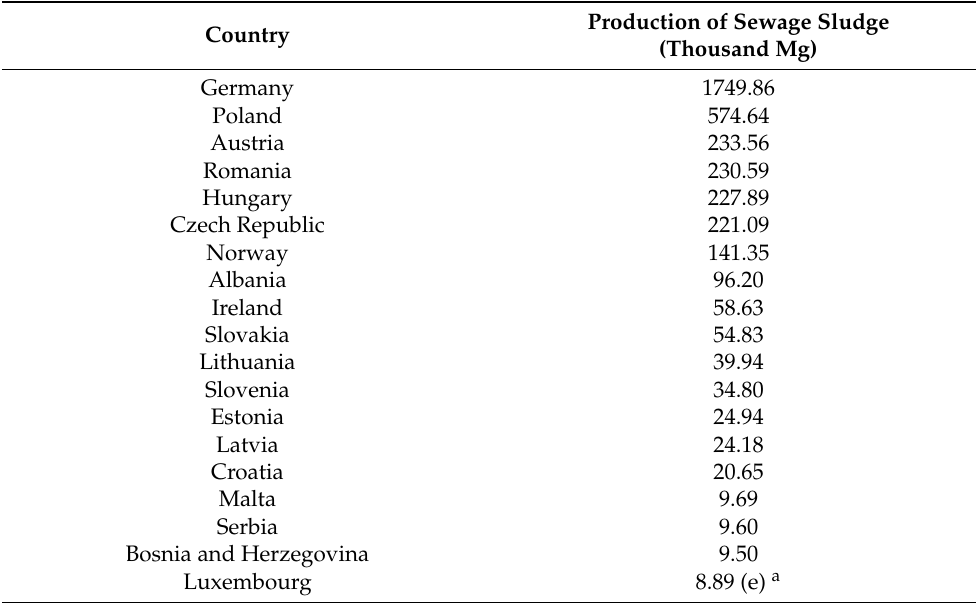
Production of Sewage